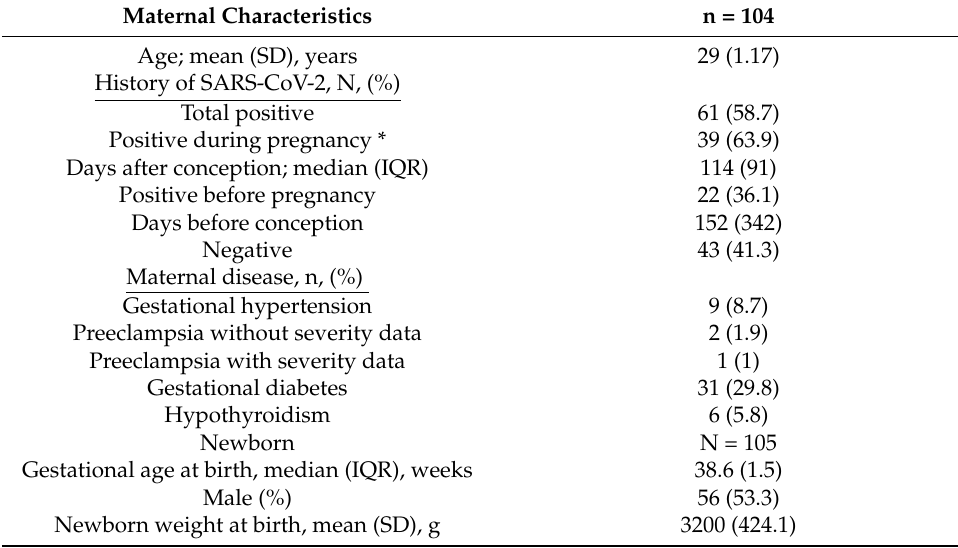
Table 1. Demographic and Clinical Characteristics.